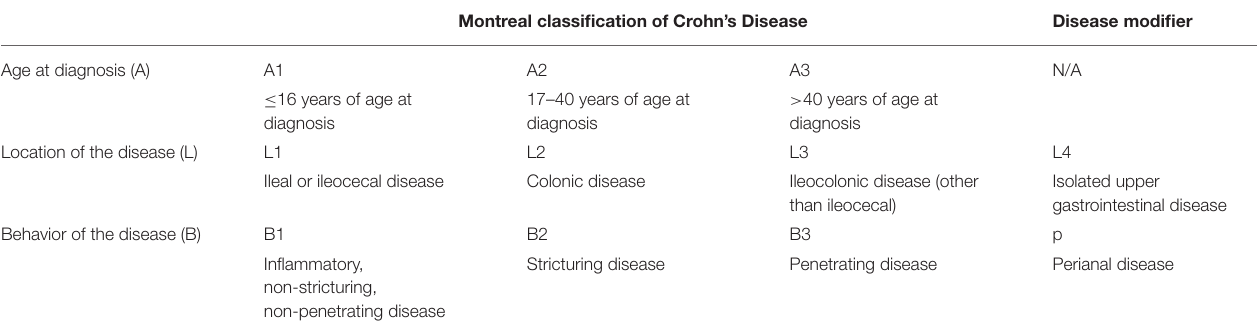
TABLE 1 | Montreal classification of Crohn’s disease